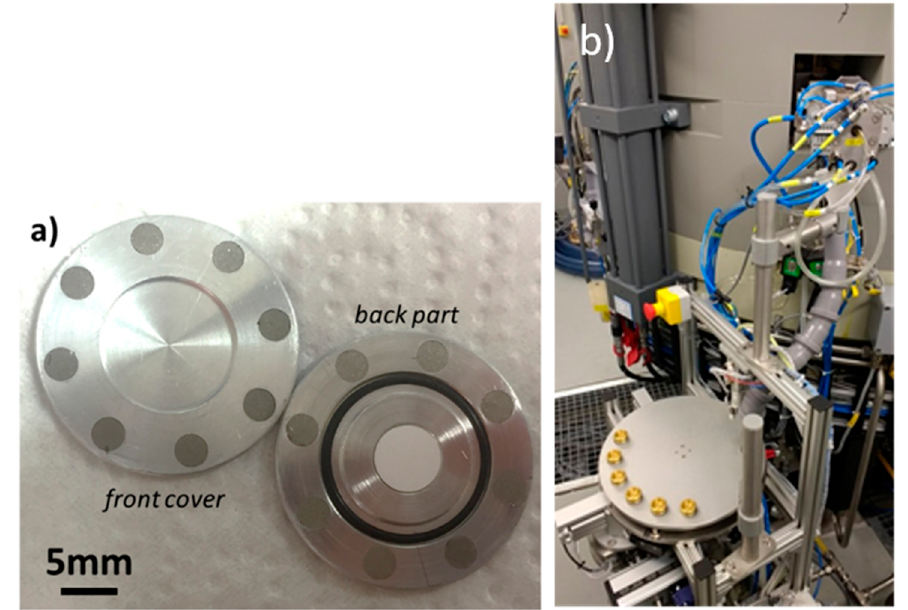
Figure 4. ( a ) Target coin containing a CaO pellet for irradiations using the solid target station at the Bern cyclotron laboratory. The front cover (lid) has a tunable beam entrance window, while the back part (cup) contains the pellet and the O-ring. Once put together, it forms a disc 24 mm in diameter and 2 mm thick. ( b ) The IBA Nirta solid target station and the solid target transfer system (STTS) installed on the Bern medical cyclotron.